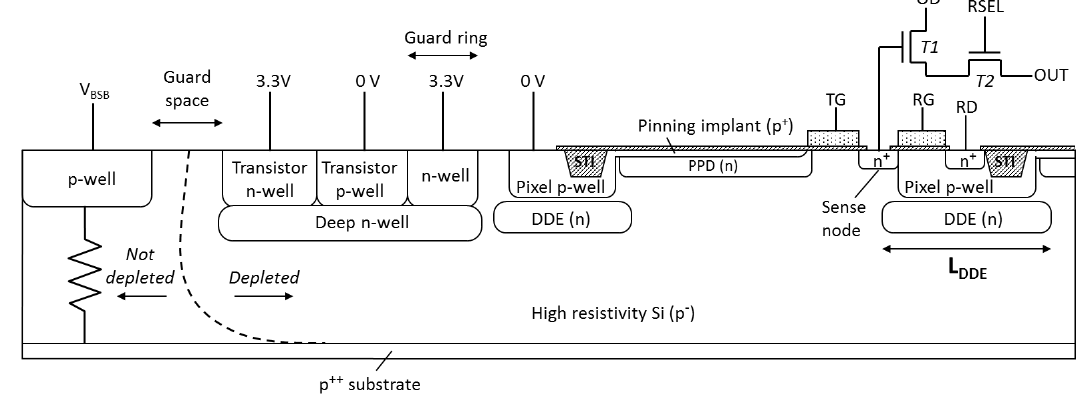
Figure 2. Cross section of the new design in a front-side illuminated (FSI) variant, showing the deep depletion extension (DDE) implant, the guard ring surrounding the pixel array, p-wells and n-wells for off-pixel transistors, and the edge p-well and its guard space for applying the reverse substrate bias from the front.